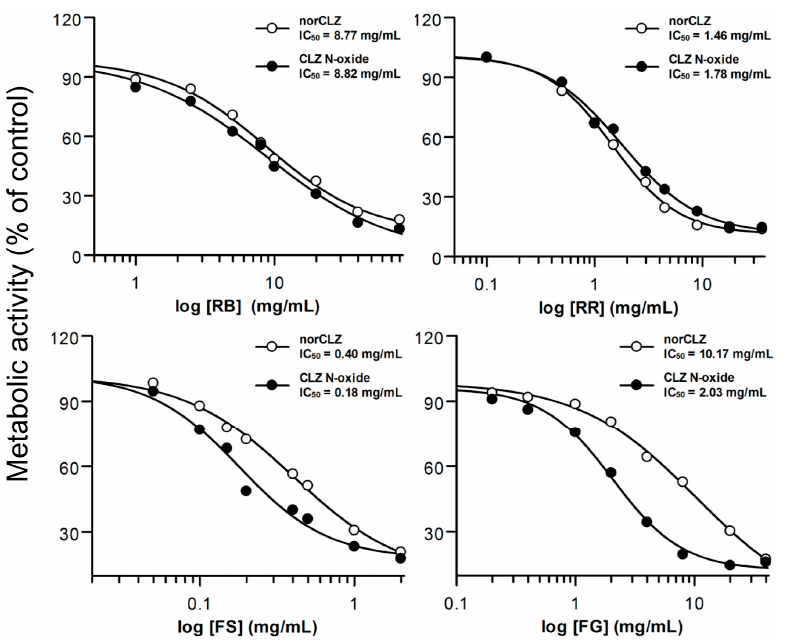
Figure 1. Inhibition of CLZ metabolism in HLMs by various concentrations of Radix Rehmanniae (RR), Fructus Schisandrae (FS), Radix Bupleuri (RB) and Fructus Gardeniae (FG). Experiments conducted in triplicate.